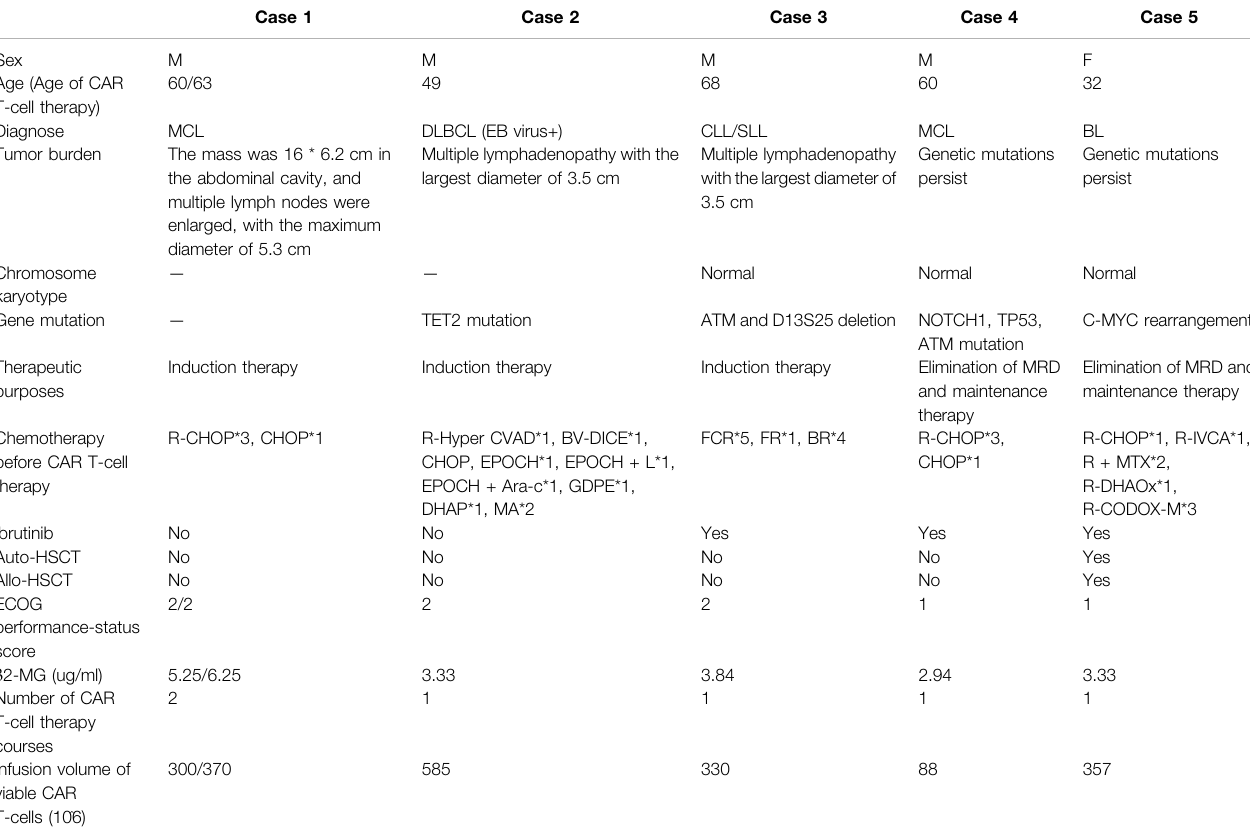
TABLE 1 | Patient characteristics before CAR T-cell therapy and dose of CAR T-cell